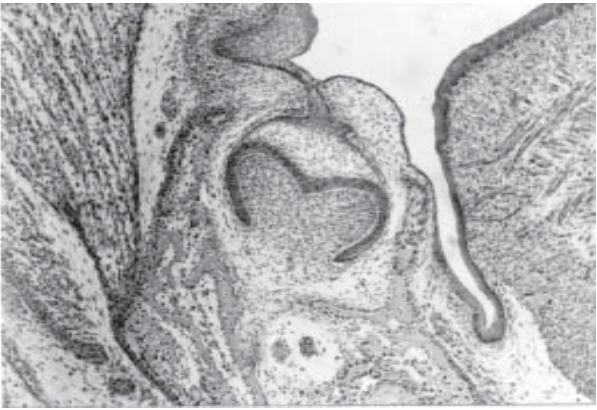
Figure 4 – Control Group – First mandibular molar germs. Cap Phase. H&E. Magnification: